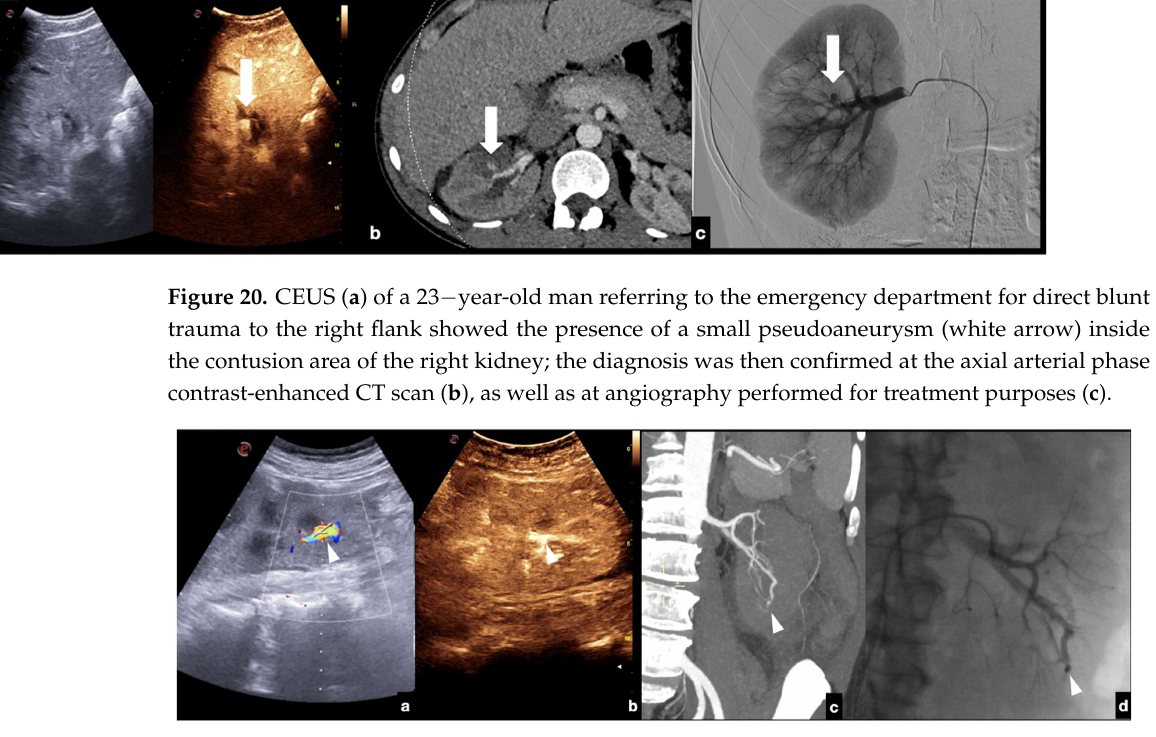
Figure 21. Companion case of Figure 2b. Renal arteriovenous fistula (white arrowhead) at color – Doppler US ( a ) and CEUS ( b ) , confirmed ( c ) at contrast-enhanced CT scan (arterial phase, coronal MIP reconstruction) and subsequent angiography ( d ).